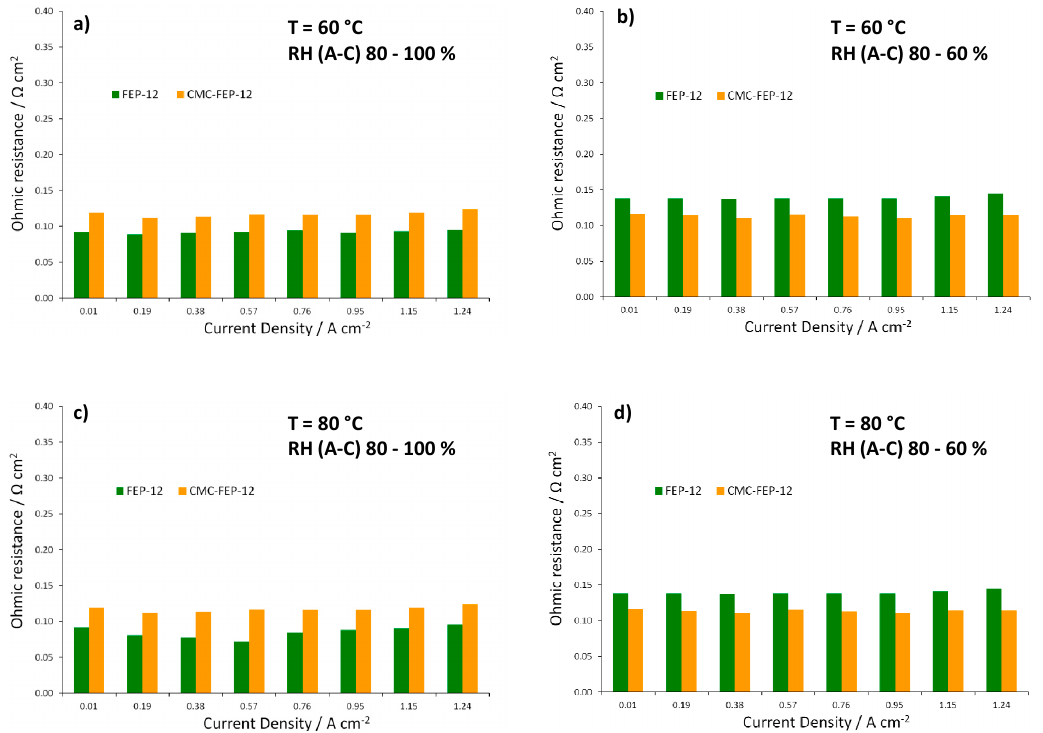
Figure 11. Trend of ohmic resistance as a function of current density for FEP-12 and CMC-FEP-12 assembled fuel cells. Operating conditions: ( a ) 60 °C, RH (A-C): 80–100%; ( b ) 60 °C, RH (A-C): 80–60%; ( c ) 80 °C, RH (A-C): 80–100%; and ( d ) 80 °C, RH (A-C): 80–60%.